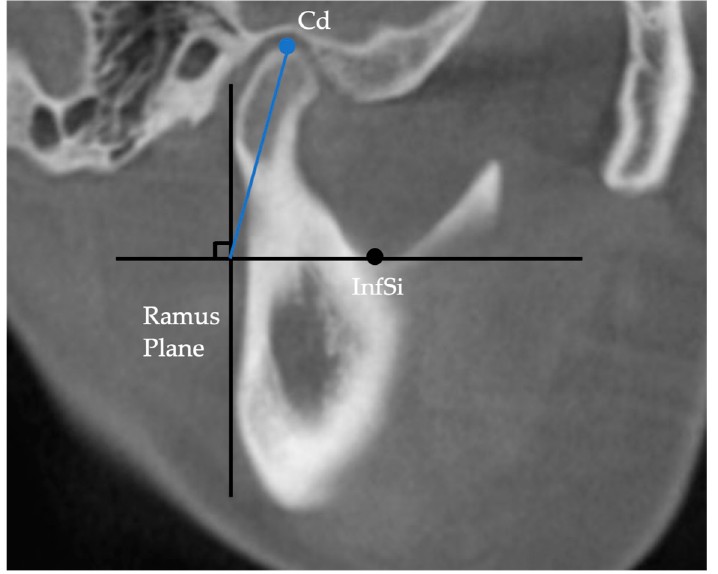
Figure 4. Facial midsagittal plane. InfSig, lowest point of the sigmoid notch; Cd, uppermost point of the condyle.